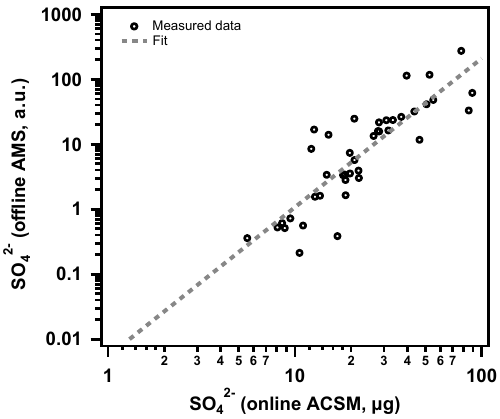
Figure 2. Offline AMS SO 2 − blank corrected concentrations com- 4 pared to theoretical SO 2 − loadings of the filter fractions (µg). The 4 theoretical SO 2 − loadings are calculated based on ambient SO 2 − 4 concentrations measured by the ACSM for the Zurich yearly cycle and the volume of air sampled through the analyzed filter fraction. Results are fitted using a power function (ln (y) = 2 . 3 × ln (x) − 5 .